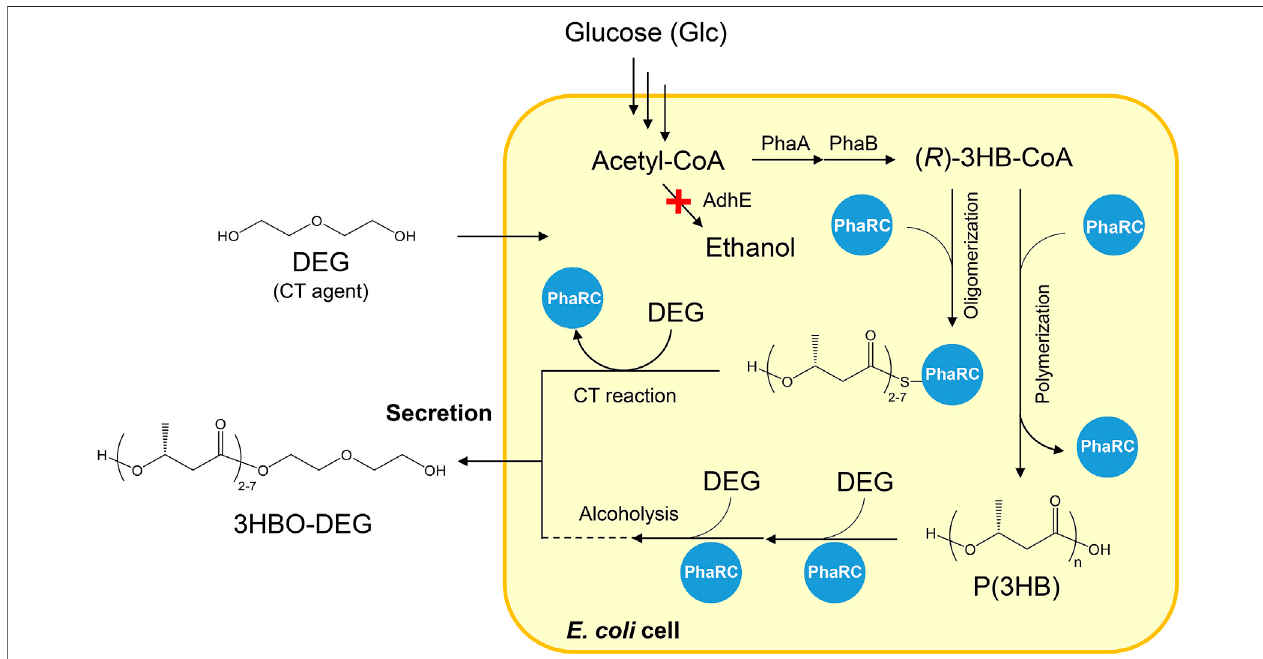
FIGURE 1 | Secretary production of 3HBO-DEG via E. coli BW25113 Δ adhE harboring pGEM- phaRC YB4 AB . AdhE: alcohol dehydrogenase, PhaA: 3-ketothiolase from R.eutropha H16,PhaB:acetoacetyl-CoAreductasefrom R.eutropha H16,PhaRC:PHAsynthasefrom B.cereus YB-4,3HB:3-hydroxybutyrate,DEG:diethylene glycol, CT: chain